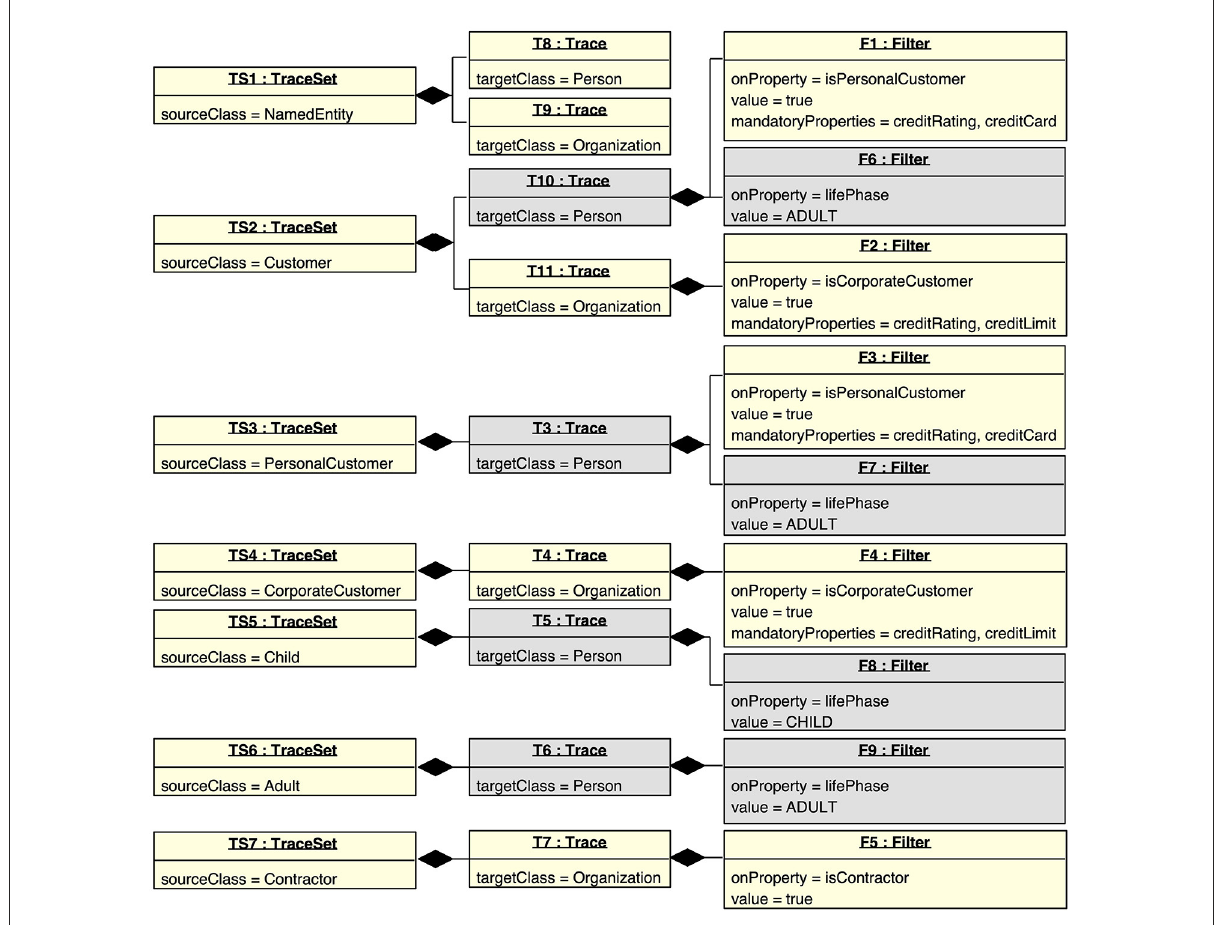
FIGURE10 Trace table after the lifting operation on the generalization set with Child and Adult